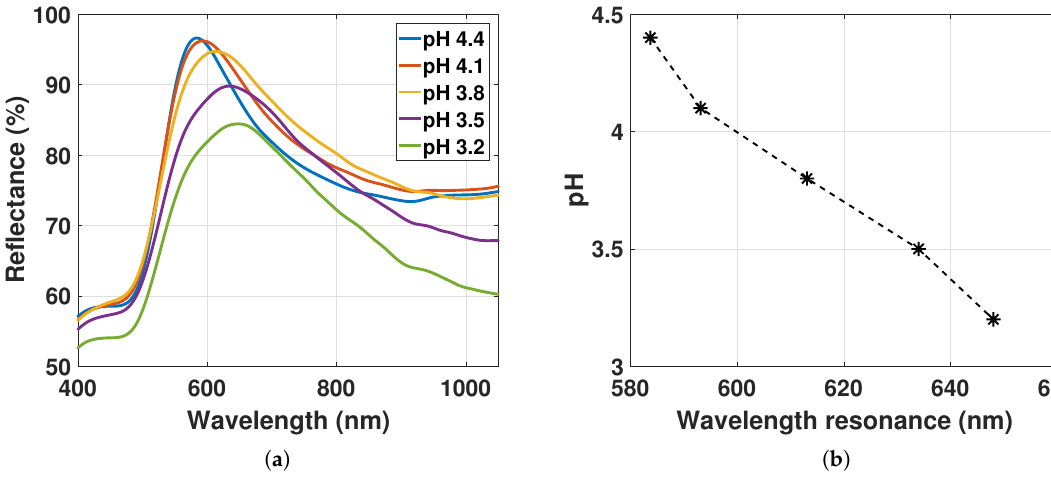
Figure 12. ( a ) Reflectance spectra of GNP-hydrogel with ND 03 at 1.7 × 10 11 particles/mL fitted with a smoothing spline function for pH 4.4 to 3.2; ( b ) LSPR peak position from Figure 12a as a function of hydrogel deswelling stimulated with pH solutions from 4.4 to